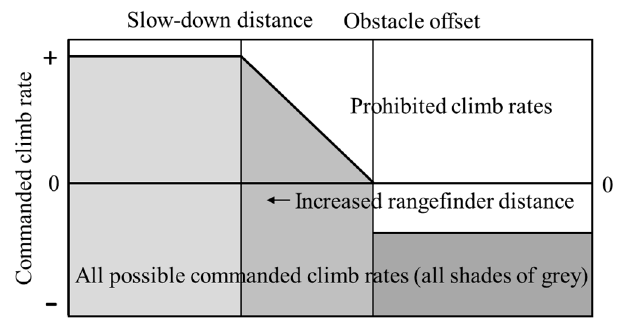
Figure 5. Allowable climb rates by pilot based off overhead standoff distance.